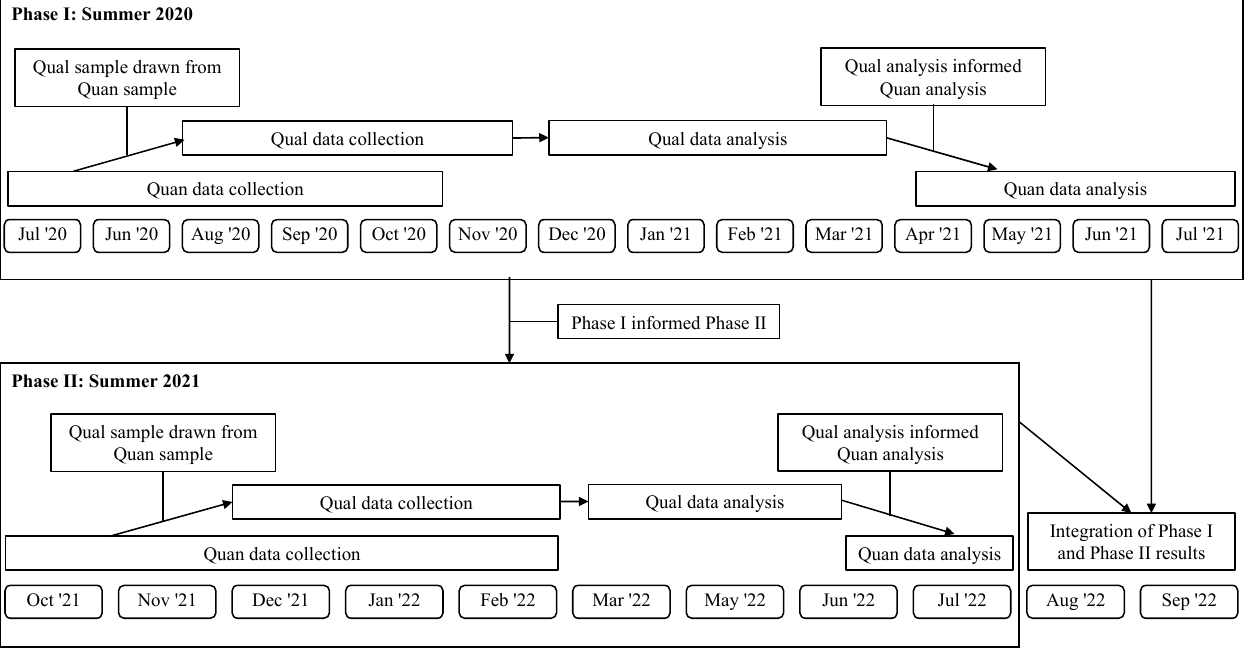
Figure 1. Visual display of multiphase explanatory sequential mixed methods study design.